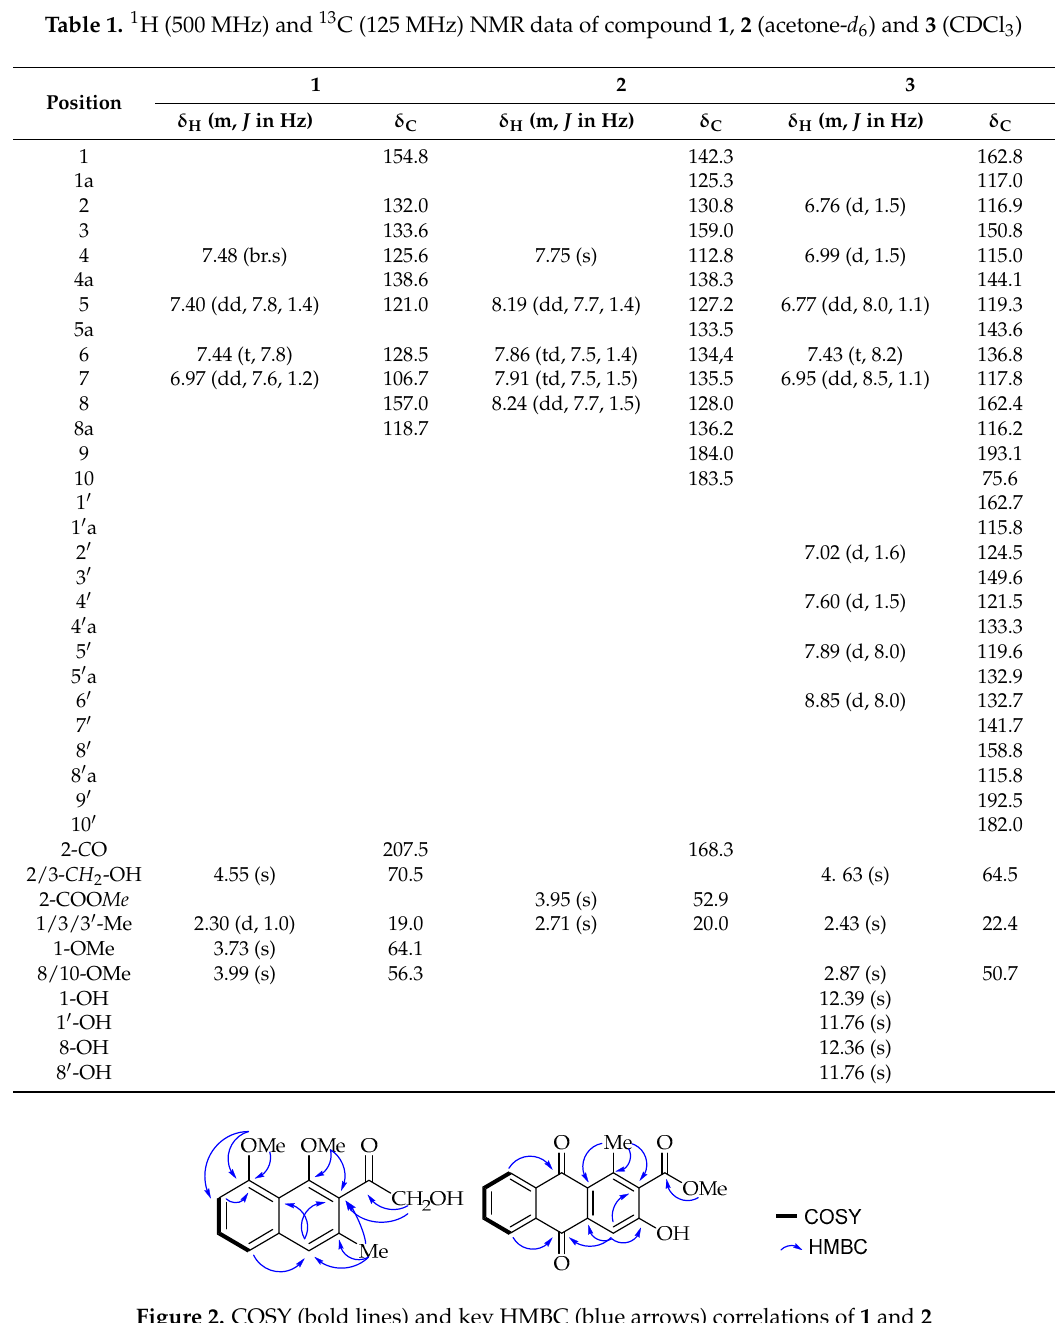
Table 1. 1 H (500 MHz) and 13 C (125 MHz) NMR data of compound 1 , 2 (acetone- d 6 ) and 3 (CDCl 3 )